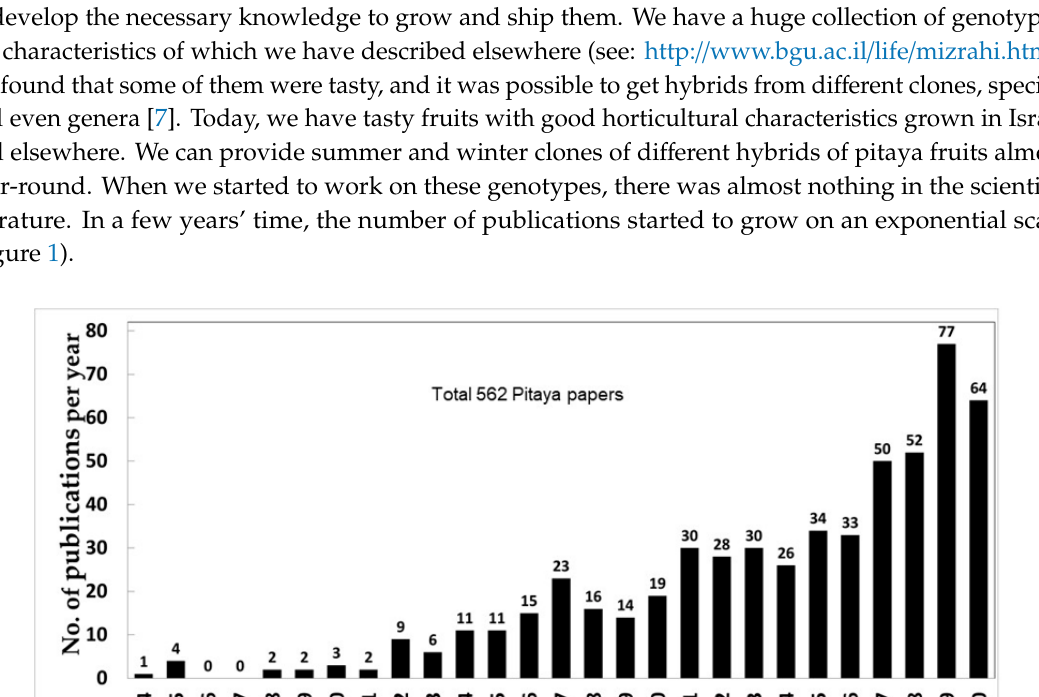
Figure 2. Fruits showing great differences among the clones of one pitaya species Hylocereus undatus.